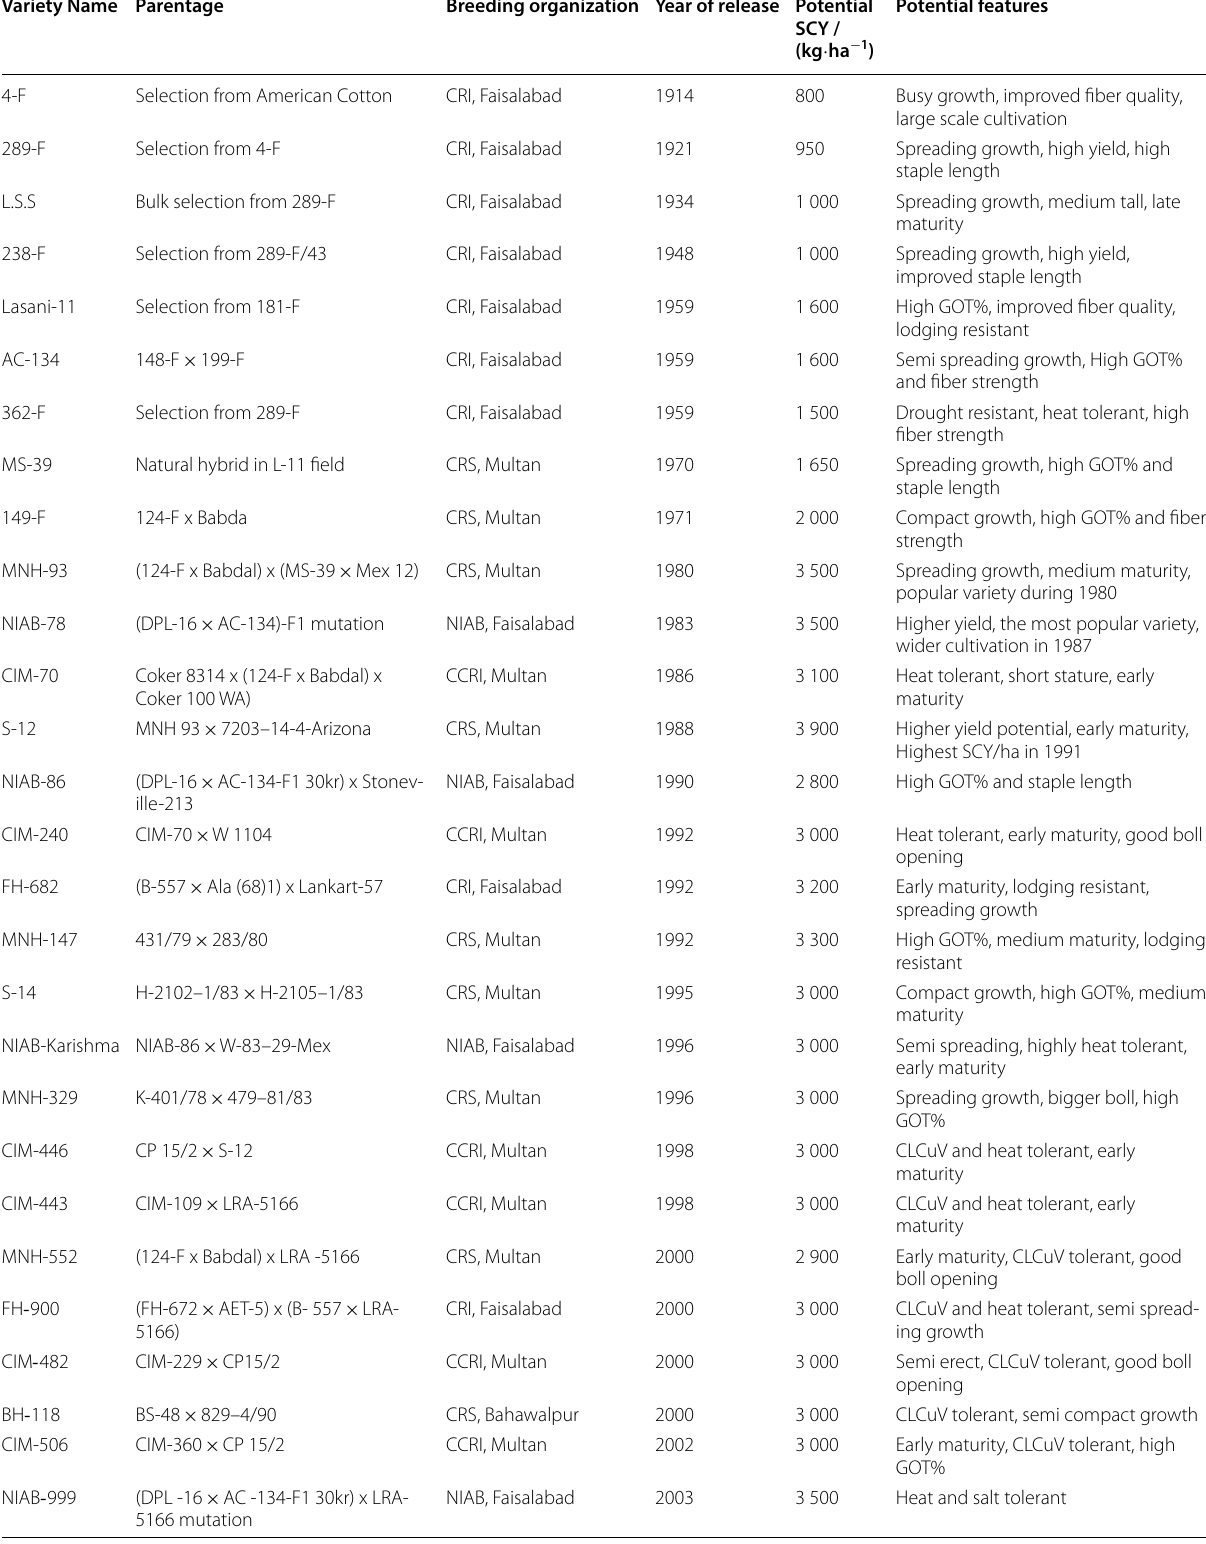
Table 1 Background of major approved upland cotton varieties of Pakistan Variety Name